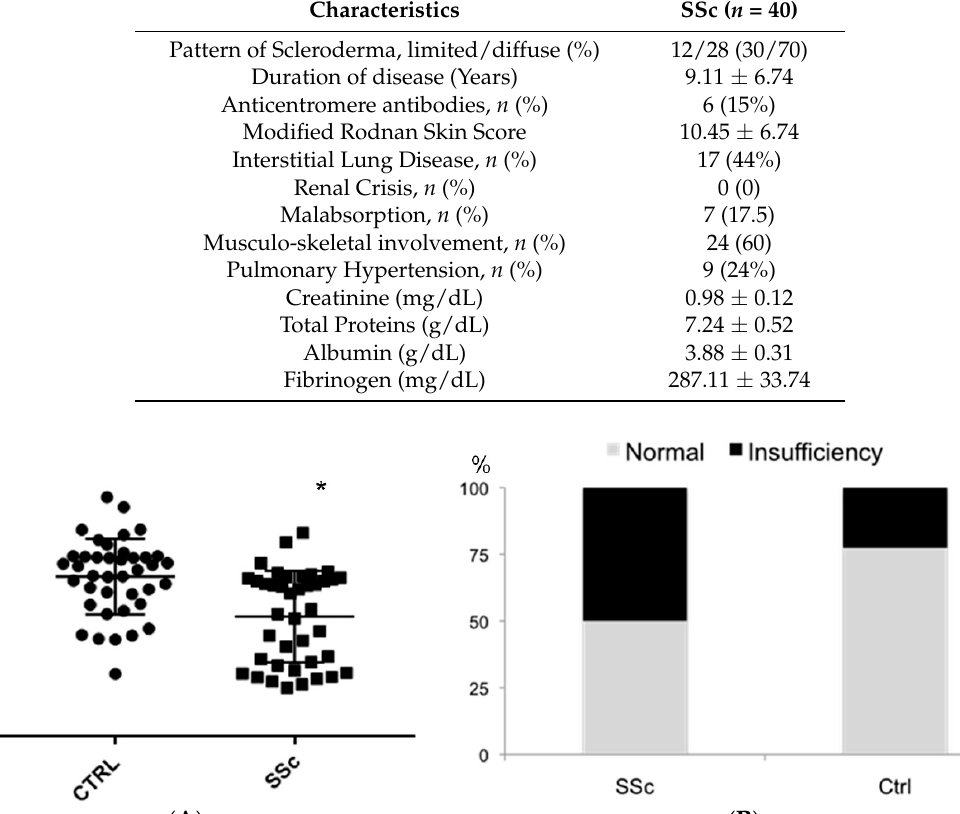
Table 2. Clinical characteristics of patients with systemic sclerosis; results are expressed as means ± SD and percentage.